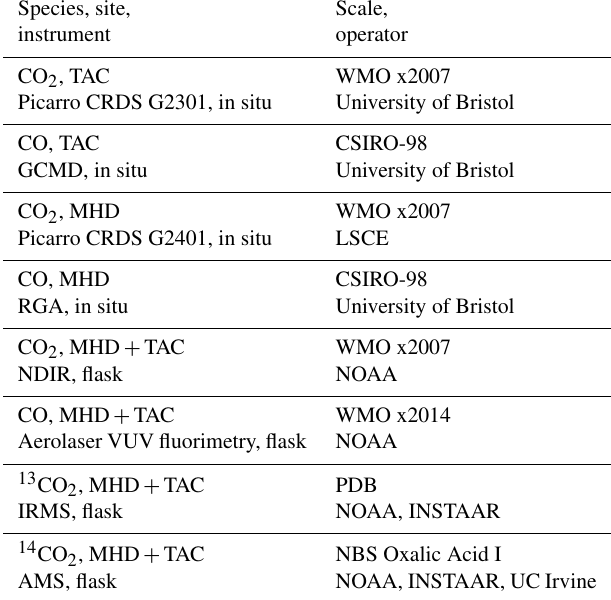
Table 1. Overview of greenhouse gas measurements presented in this paper. The acronyms used to describe instruments are cavity ring-down spectroscopy (CRDS), gas chromatography mass detec- tor (GCMD), residual gas analyser (RGA), nondispersive infrared detector (NDIR), vacuum ultra violet (VUV) infrared mass spec- trometer (IRMS), and accelerator mass spectrometer